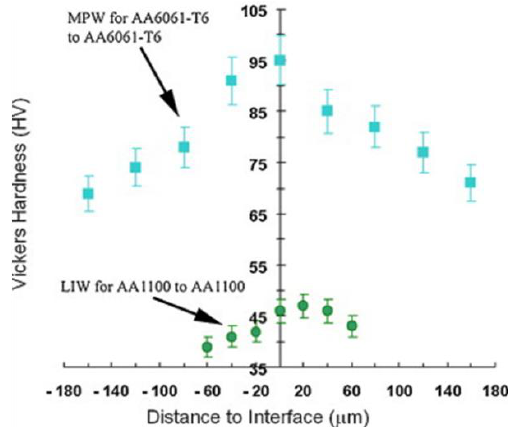
Figure 17. Hardness of weld interface with MPW (Magnetic Pulse Welding) and LIW (Laser Impact Welding) (reproduced from [33], with permission of Elsevier